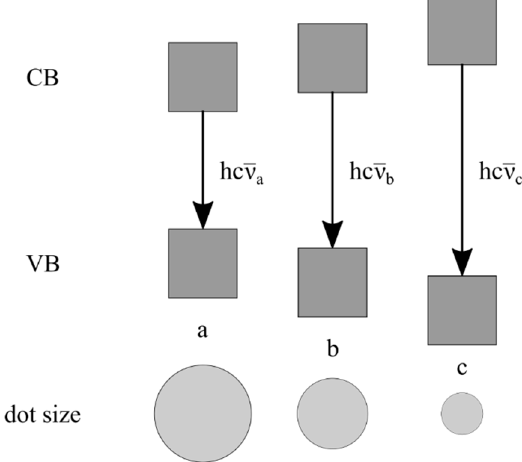
Figure 17. Luminescent quantum dots (QDs) showing the correlations between quantum dot size, the band gap between the conduction (CB) and valence bands (VB), and the photon emission energy.